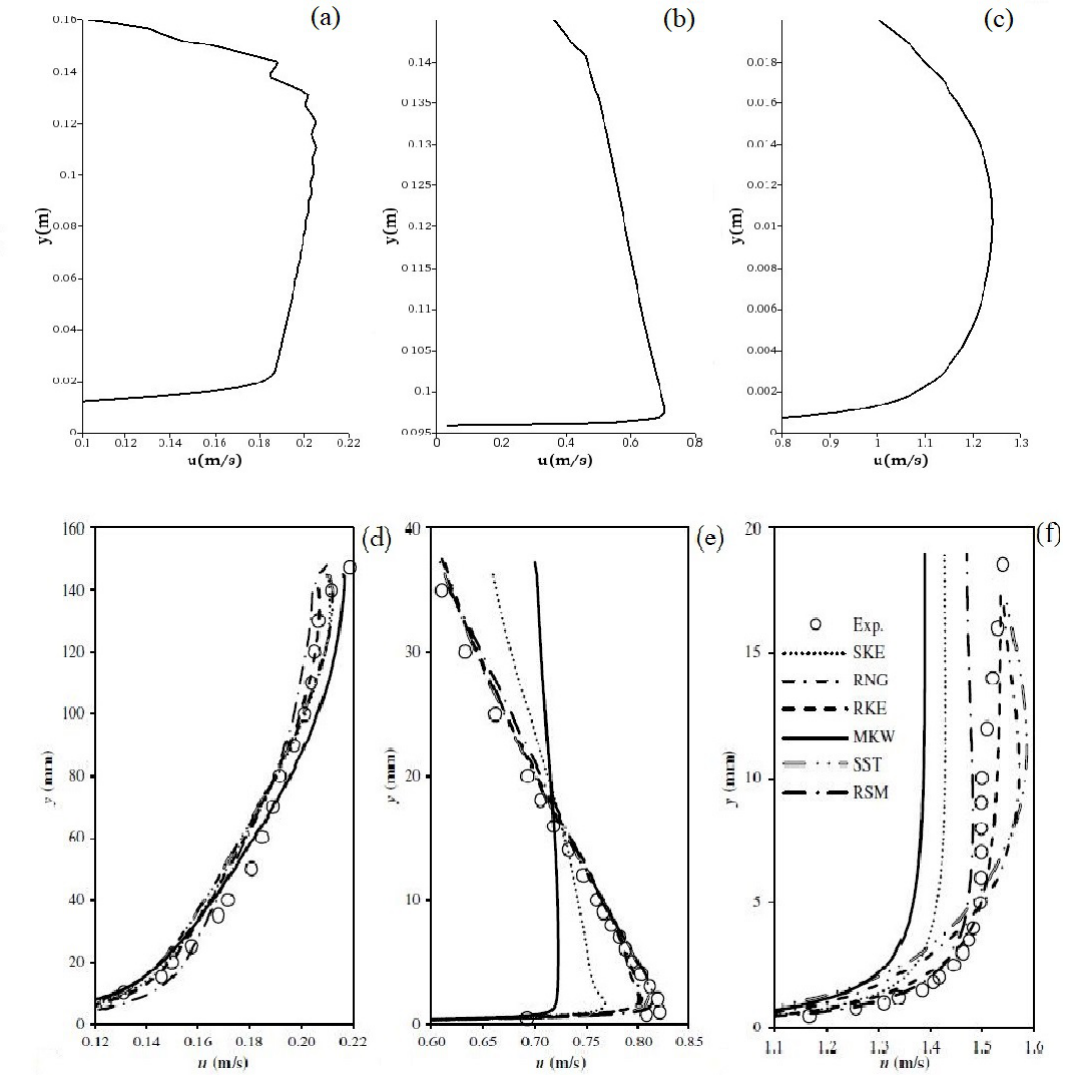
Figure 10. Horizontal velocity profiles obtained with caffa3d for sections: ( a ) x = 0.8 m; ( b ) x = 1.0 m; ( c ) x = 1.3 m, and by experiments and simulations [33] for sections: ( d ) x = 0.8 m; ( e ) x = 1.0 m; ( f ) x = 1.3